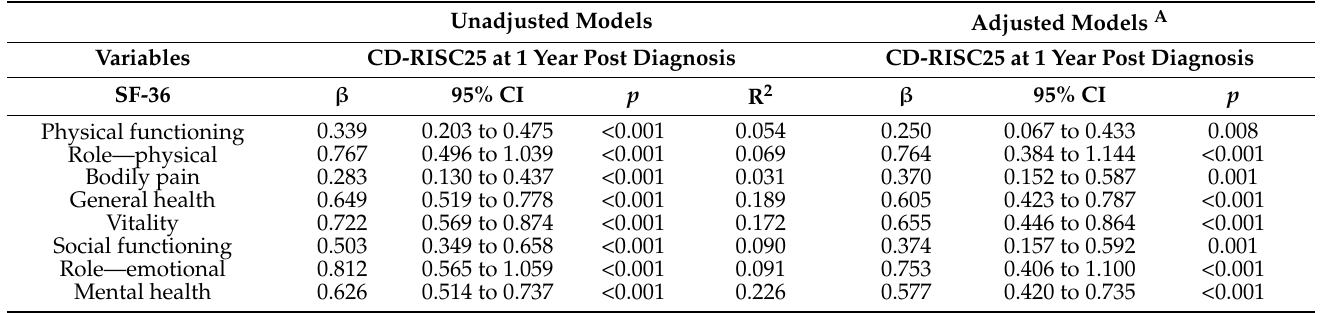
Table 5. Uni- and multivariable linear regression analyses between psychological resilience (CD-RISC25) and health-related quality of life (SF-36) at 1 year post